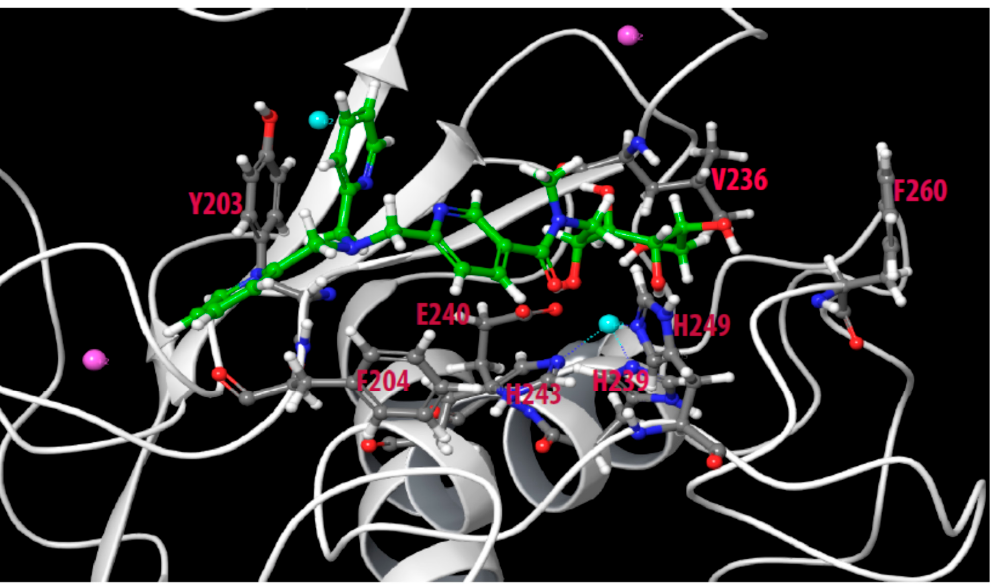
Figure 8. Docking of Zn148 into the catalytic site of MMP-14. Some of the most important amino acids for binding Zn148 are shown. Color coding as in Figure 5.